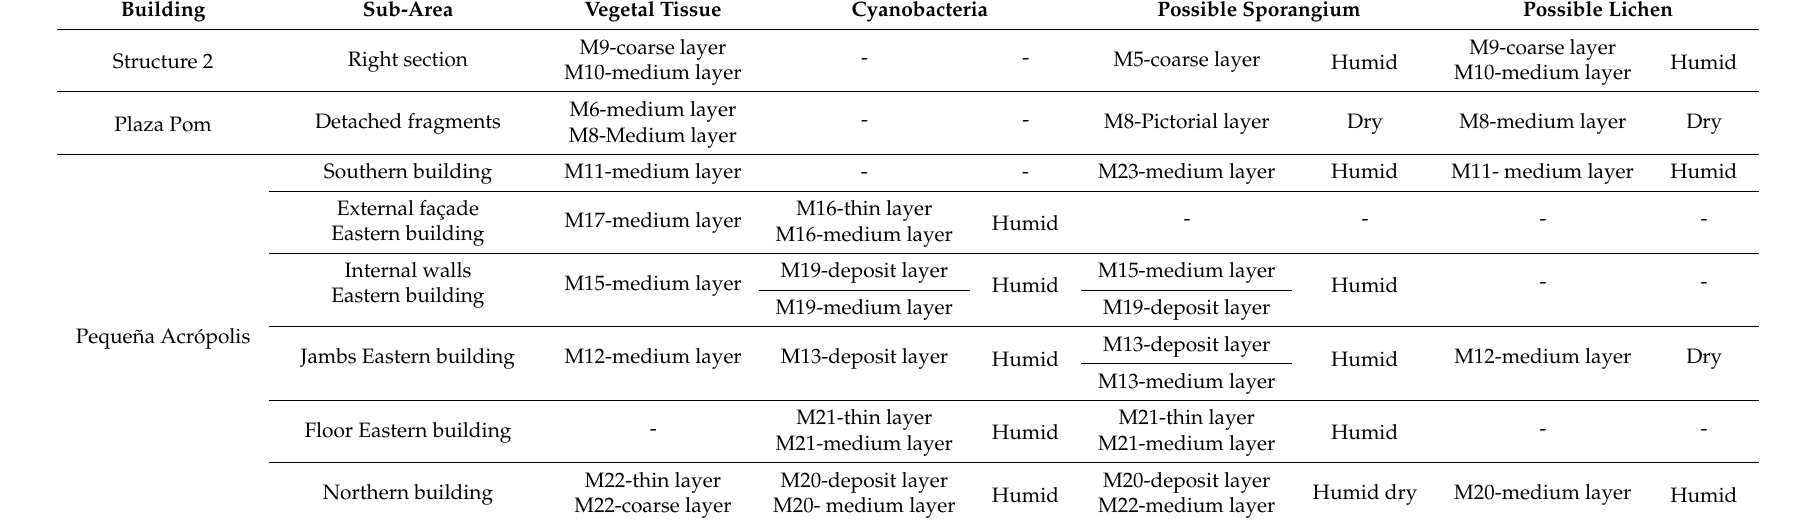
Table 11. Samples and layers in which organic inclusions could be found in thin sections; also it is important to point out the state of humidity of the plaster.